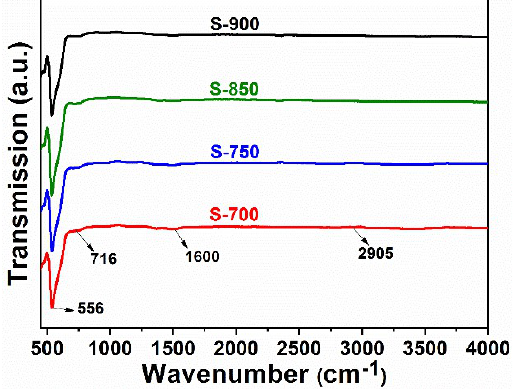
Figure 4. FT-IR spectra of LaFeO 3 nanoparticles calcined at different temperatures.